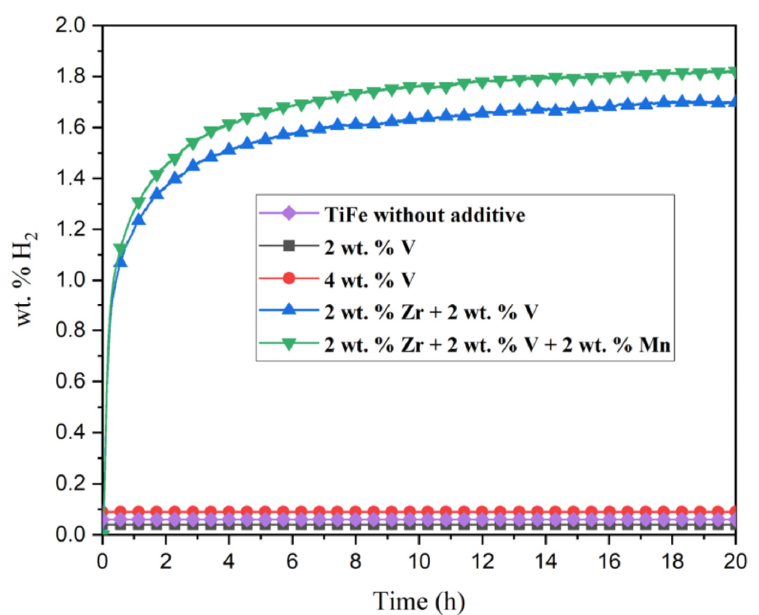
Figure 6. Activation kinetics of TiFe alloy with V, Zr + V and Zr + V + Mn under 20 bar H 2 pressure at room temperature. The without additive curve is reproduced with permission from Patel et al., Microstructure and first hydrogenation properties of TiFe alloy with Zr and Mn as additive; published by Elsevier,